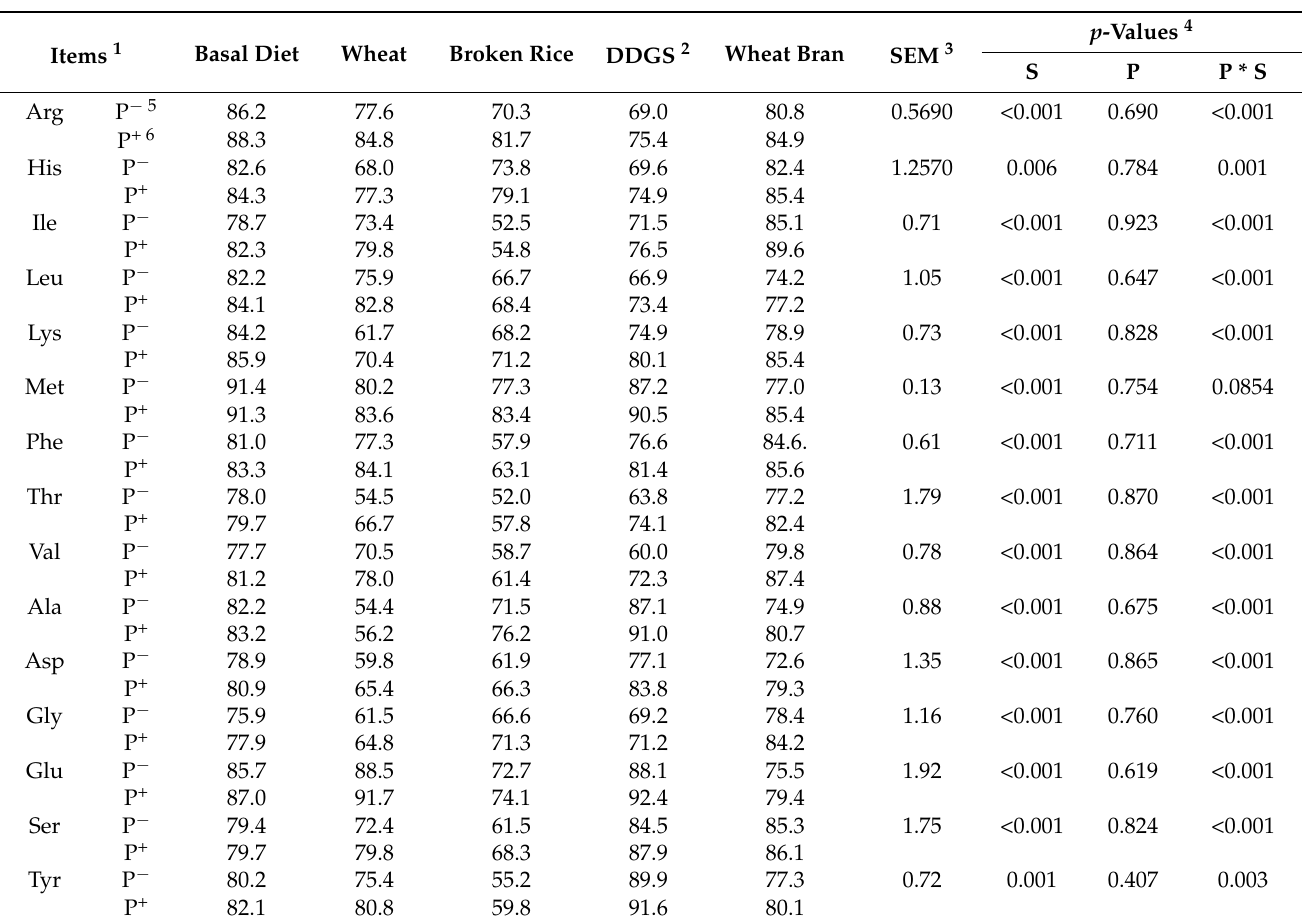
Table 8. Effect of diet supplementary with phytase on apparent total tract digestibility of amino acids in